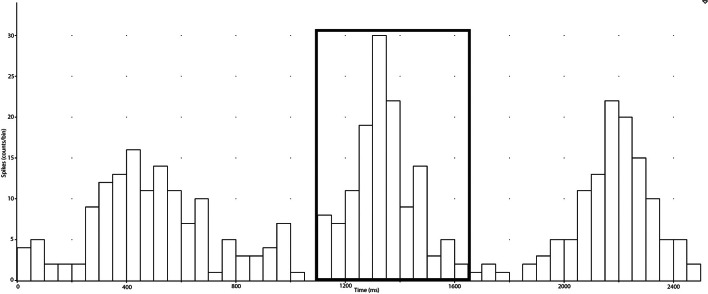
Post-stimulus time histograms were used to measure the timing of neural spikes relative to cardiac beats (R-R intervals) of the selected period (collected in the spike train). MSNA, which is cardiac-locked, can be measured ~1200 ms after an R-R interval and the elevation of counts around this time is selected and the sum of the counts is recorded as the number of spikes during the selected period.